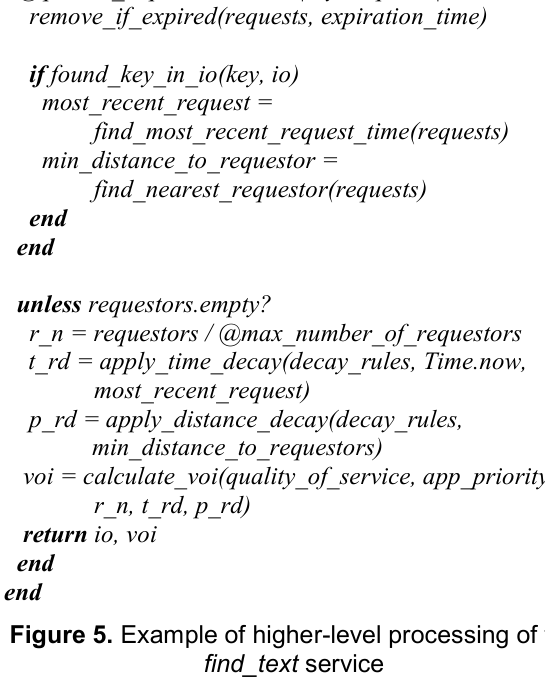
Figure 5. Example of higher-level processing of